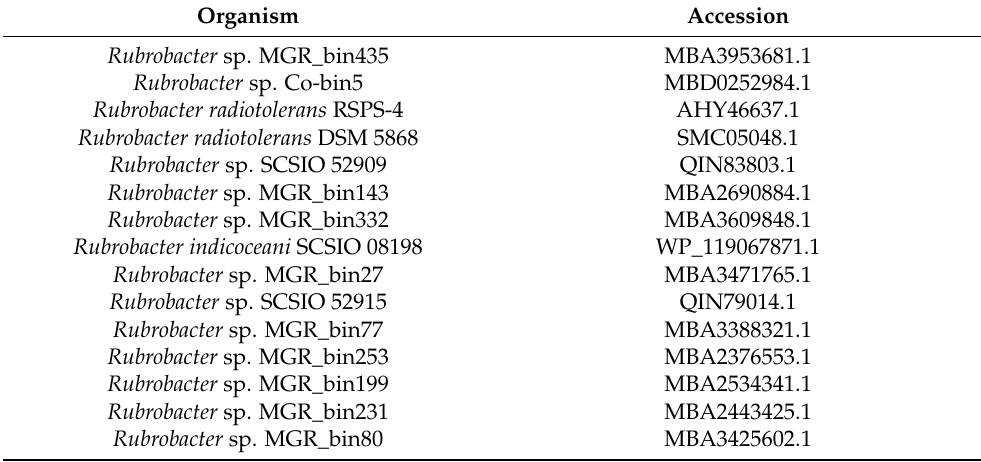
Overview of extracellular dPHAscl depolymerases identified in members of the Rubrobacter